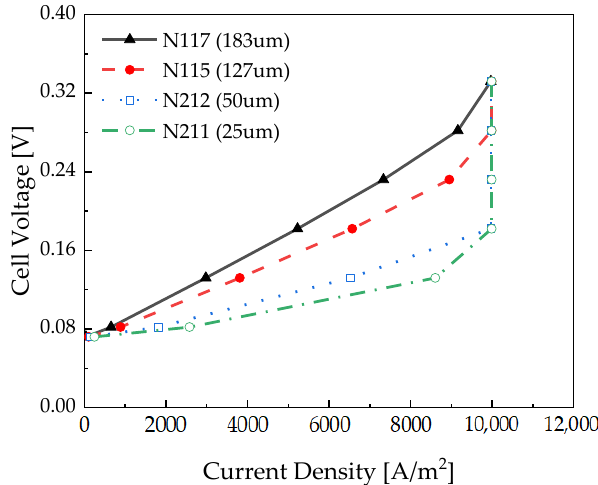
Figure 9. Polarization curve of the pseudo-2D electrochemical hydrogen compressor according to the polymer electrolyte membrane thickness.